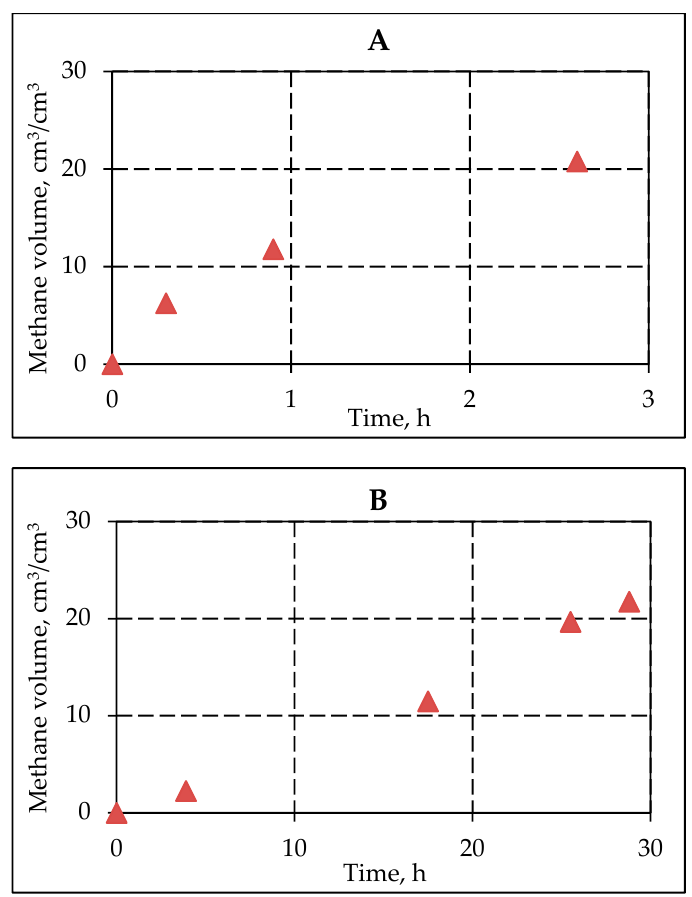
Figure 10. Methane emission in frozen hydrate saturated samples of sand (sand 1) during the gas hydrate dissociation in the pore space as a result of interaction with 0.2 N NaCl salt solution at temperatures ‒ 2.5 °C ( А ) and ‒ 4 °C ( B ).